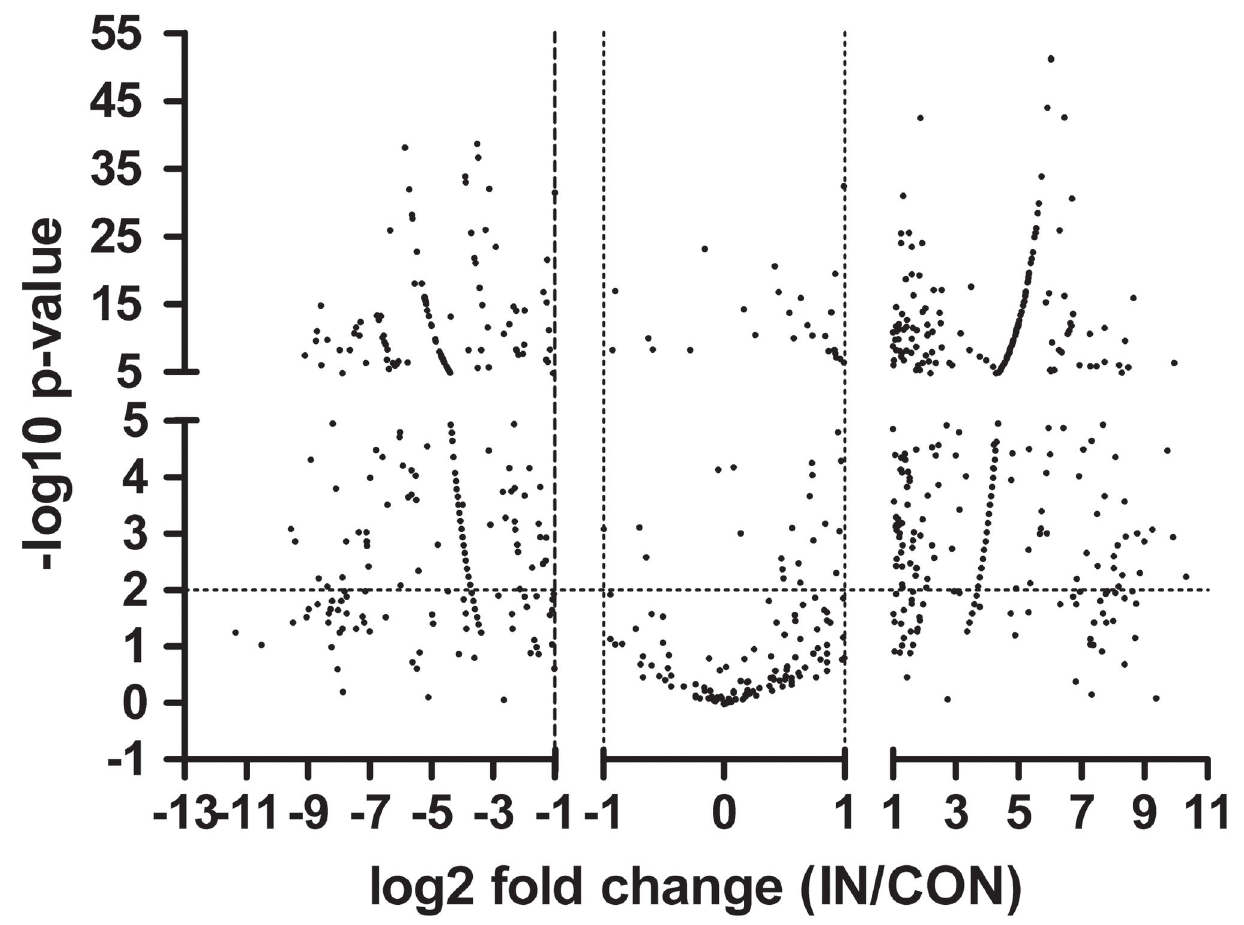
Figure 2. Global expression analysis of T. reesei sRNAs. A volcano plot shows the magnitude (fold change; x-axis) and significance ( P -value; y-axis) of the unique sRNAs between IN and CON samples. The horizontal dashed line indicates the threshold of statistical significance ( P -value= 0.01). The vertical dashed line shows the fold changes of 2.0 (log were divided into three groups based on the fold changes (IN/CON) : (1) up-expressed sRNAs: log expressed sRNAs: -1.0<log fold change<1.0; (3) down-expressed sRNAs: log 2 doi: